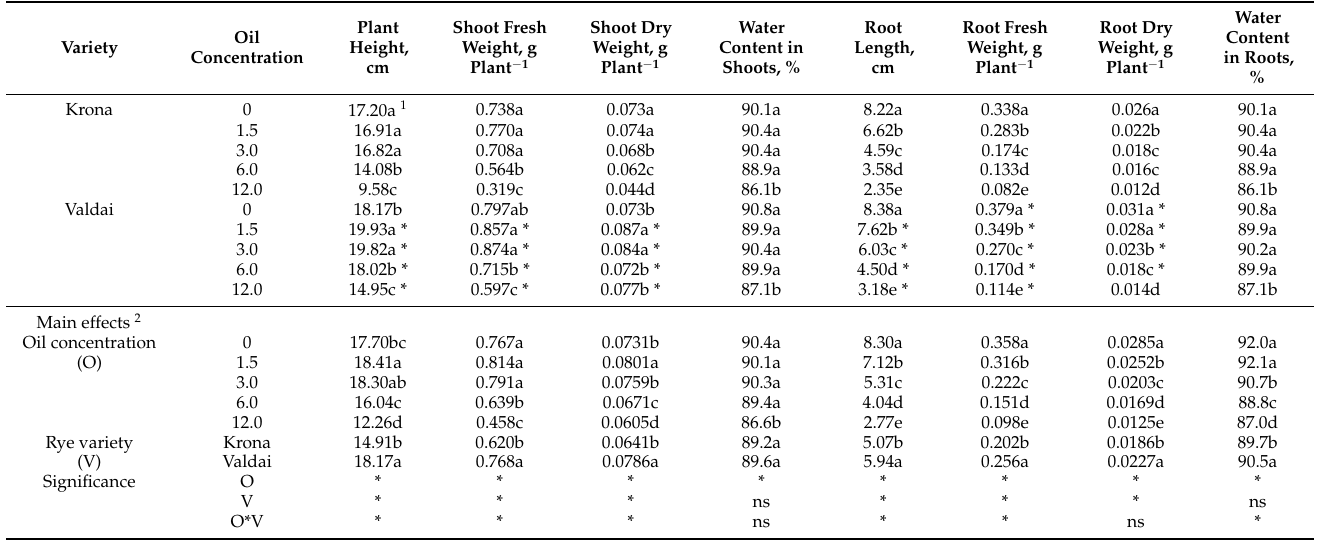
Table 1. Effect of different concentrations of crude oil in the soil on growth-related attributes of two rye varieties.